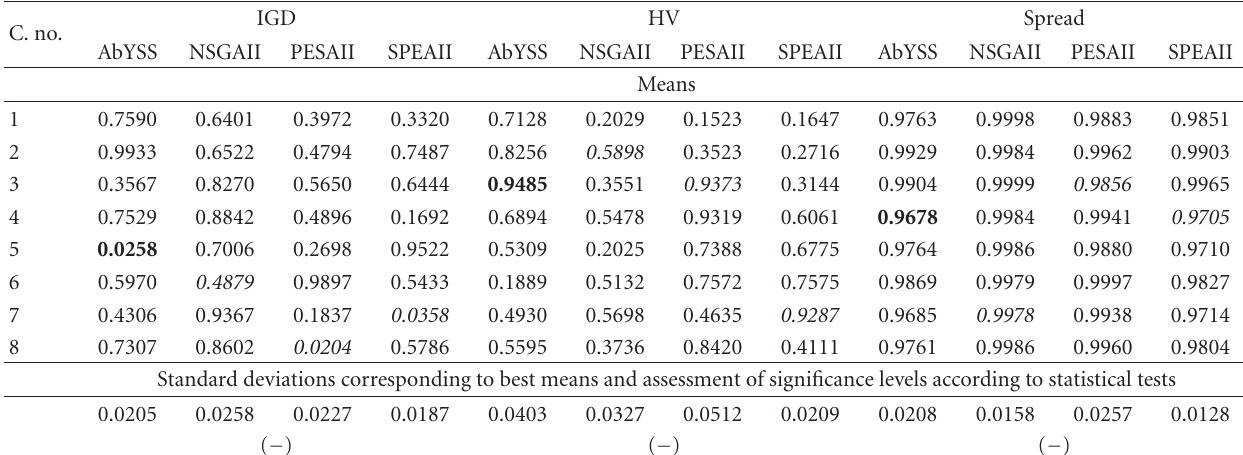
Table 6: Values of measurement quantities obtained by “Eval. Number = 1,000” and “Pop. Size = 50” for design example 3. C.